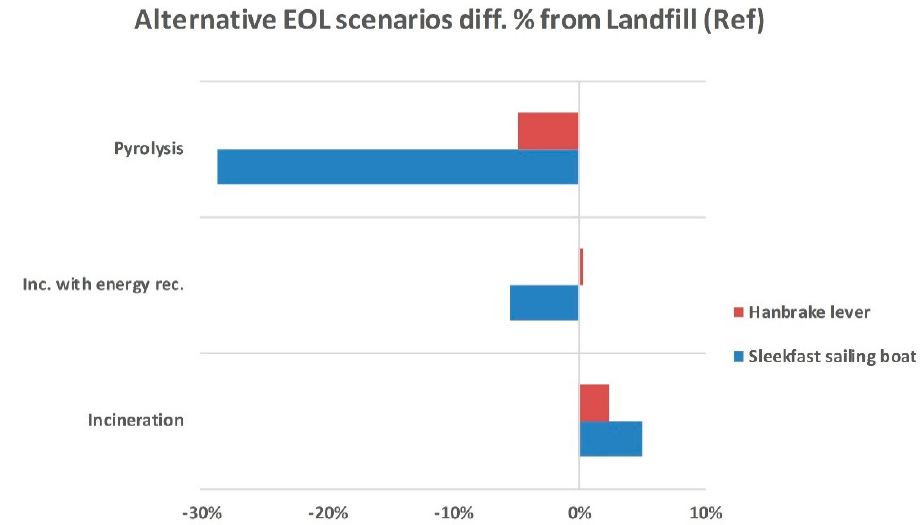
Figure 8. Percentage difference in climate change impact of the alternative EOL scenarios compared with the reference.